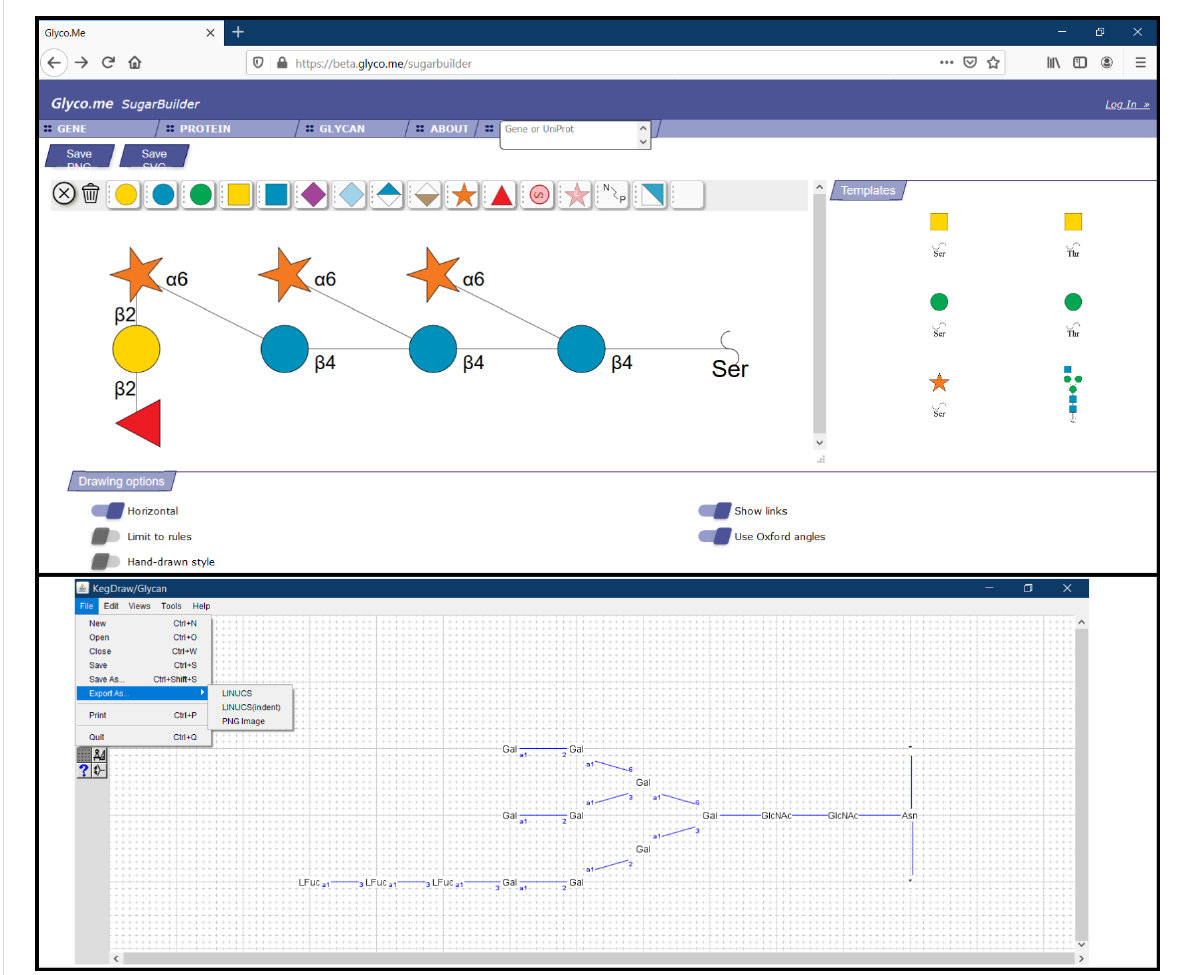
Figure 8: From top to bottom: Glyco.me SugarBuilder [56] interface with a glycan structure showing options to define anomericity and monosaccha- ride linkage position. KegDraw [57] interface with a glycan structure and available options to save the structure file in different formats.